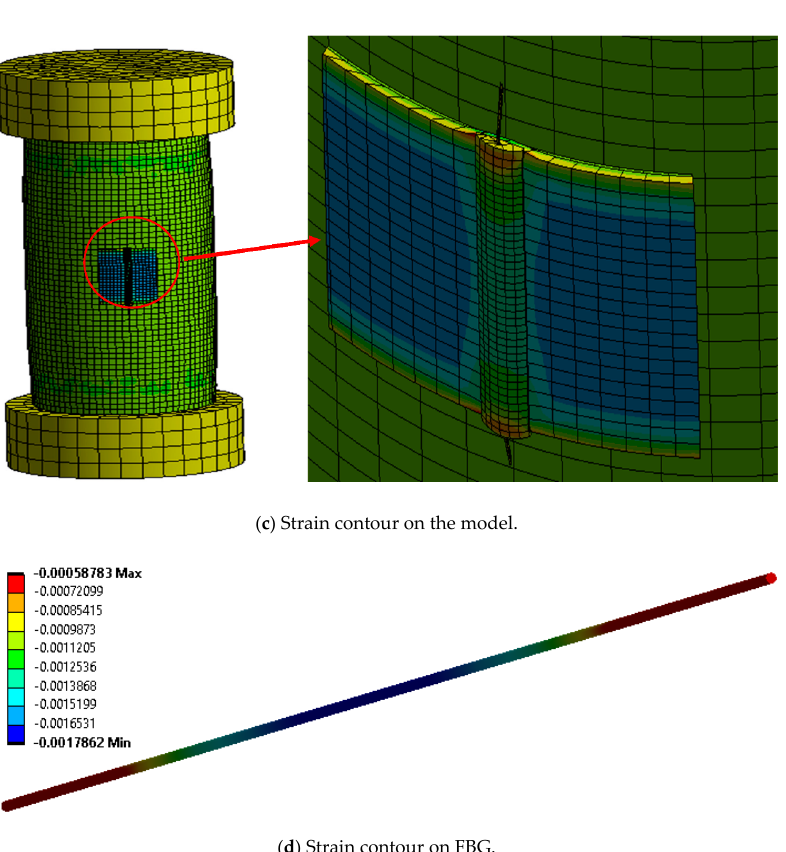
Figure 8. Finite element modeling (FEM) analysis.